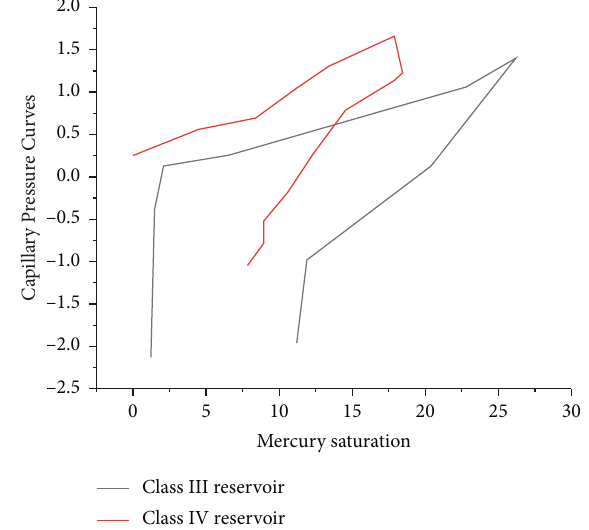
Figure 4: Capillary pressure curve of class III reservoir and class IV